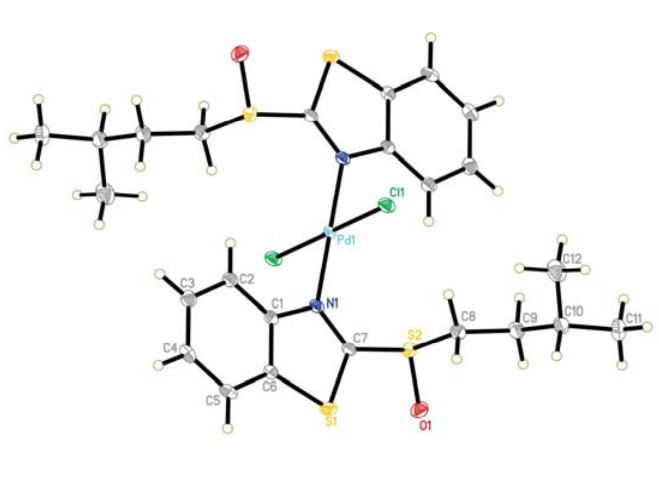
(ABSO) and the atomic labeling 2 2